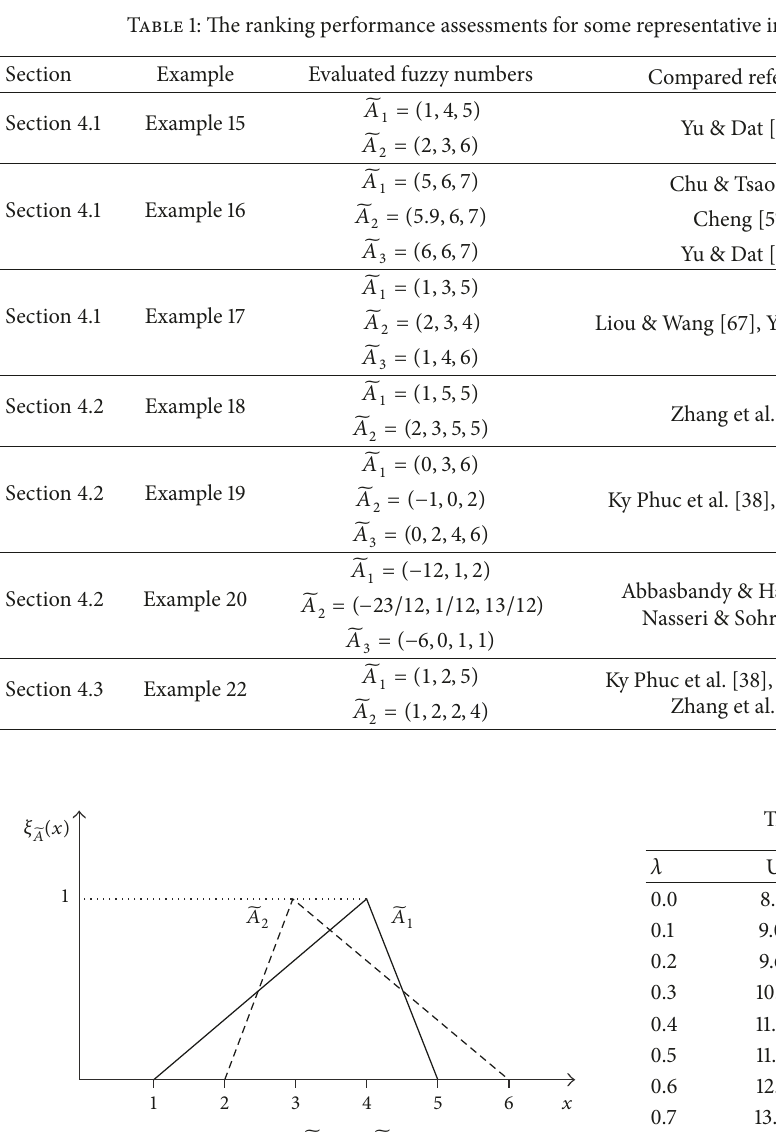
Figure 3: Fuzzy numbers